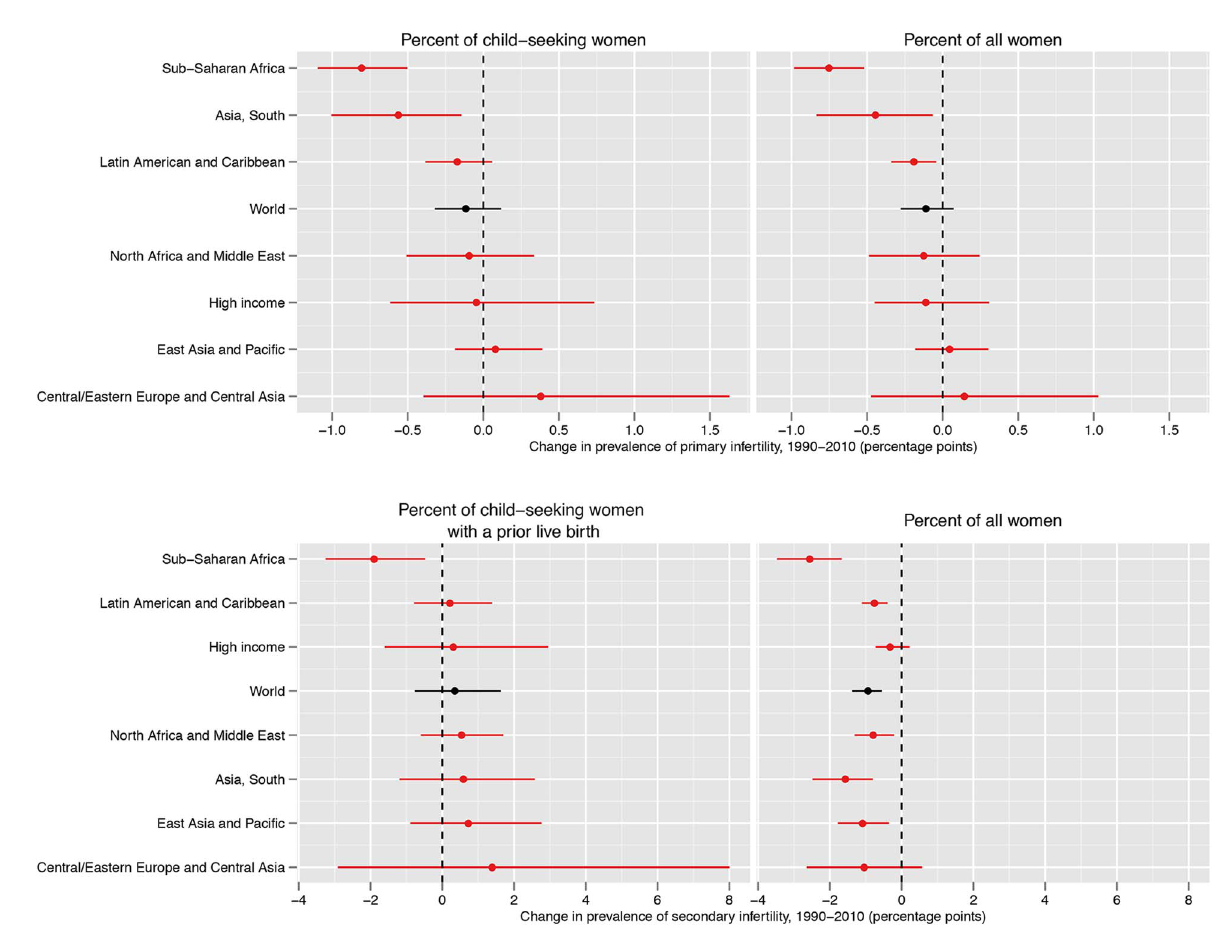
Figure 5. Absolute change in prevalence of primary and secondary infertility, measured as the percent of women who seek a child and as the percent of all women of reproductive age, between 1990 and 2010. Infertility prevalence is indexed on the female partner; change in age-standardized prevalence among women aged 20–44 y is shown here. Horizontal lines indicate the 95% uncertainty interval.